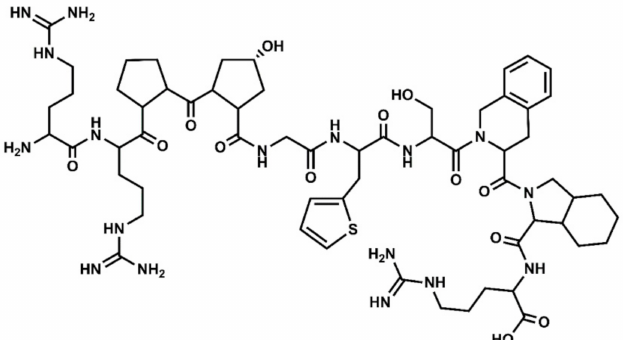
Figure 2. Chemical structure of icatibant, together with its residue sequence. Hyp = hydroxylproline; Thi = thiophenyl-alanine; Tic = 1,2,3,4-tetrahydroisoquinolin-2-ylcarbonyl; Oic = (3aS,7aS)-octahydroindol-